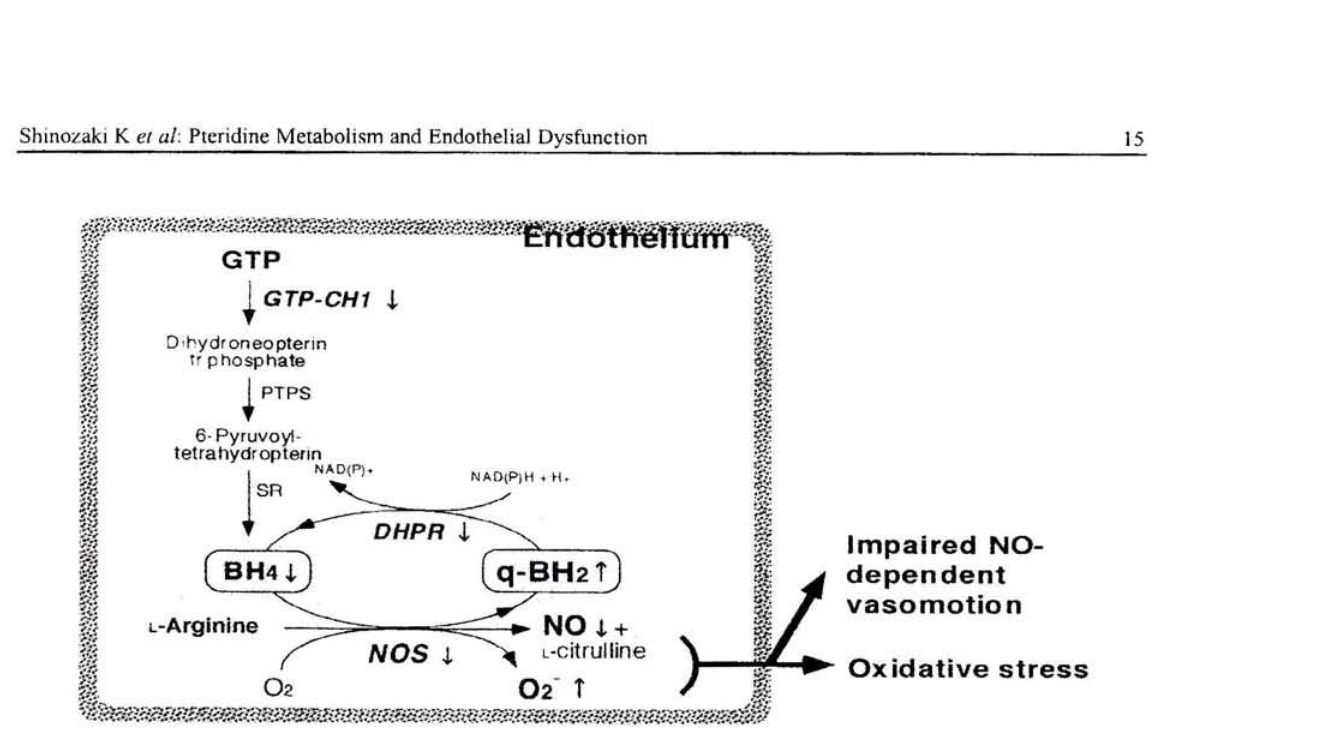
Figure. Possible mechanism of impaired endothelial dysfunction in the insulin-resistant State. GTP, guanosine triphosphate; BH4, tetrahydrobiopterin: q-BHi. quinonoid 6.7(8H)'dihydrobiopterin: GTP-CHl, GTP cyclohy- drolase i; PTPS, 6-pyruvoyl tetrahydropterin synthase: MOS. nitric oxide synthase; SR, sepiapterin reductase; DHPR, dihydropteridine